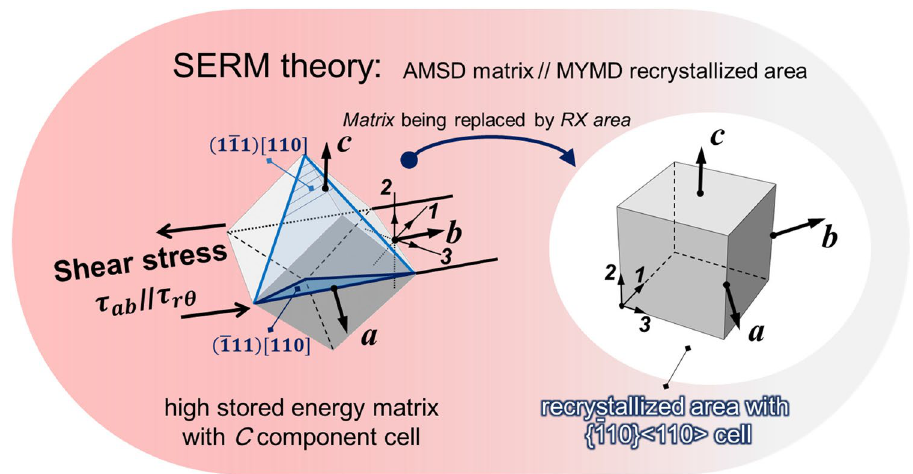
Figure 8. Illustration of the assumed C component 3D cubic cell in deformation state (left) and ideal − 1 10 } <110> component 3D cubic cell in the recrystallized state (right); the sample local Cartesian coordinate { system a – b – c and stress principal coordinate 1–2–3 are illustrated, and the local Cartesian coordinates a , b and c are parallel to the sample cylindrical coordinates r, θ and z , respectively.